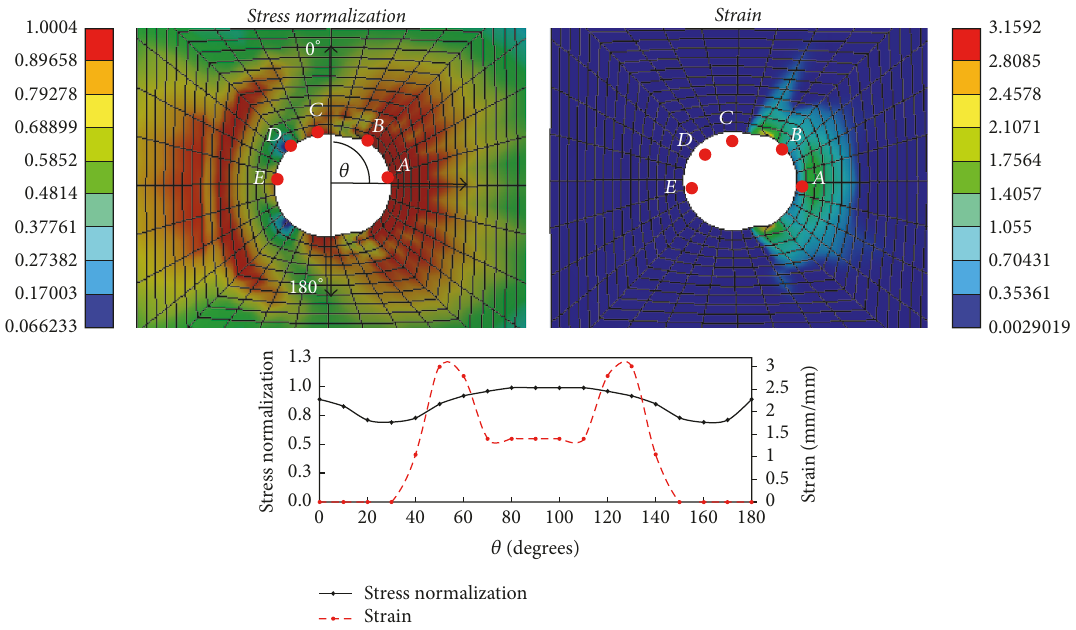
Figure 6: Stress normalization and strain distribution of bolt connection.